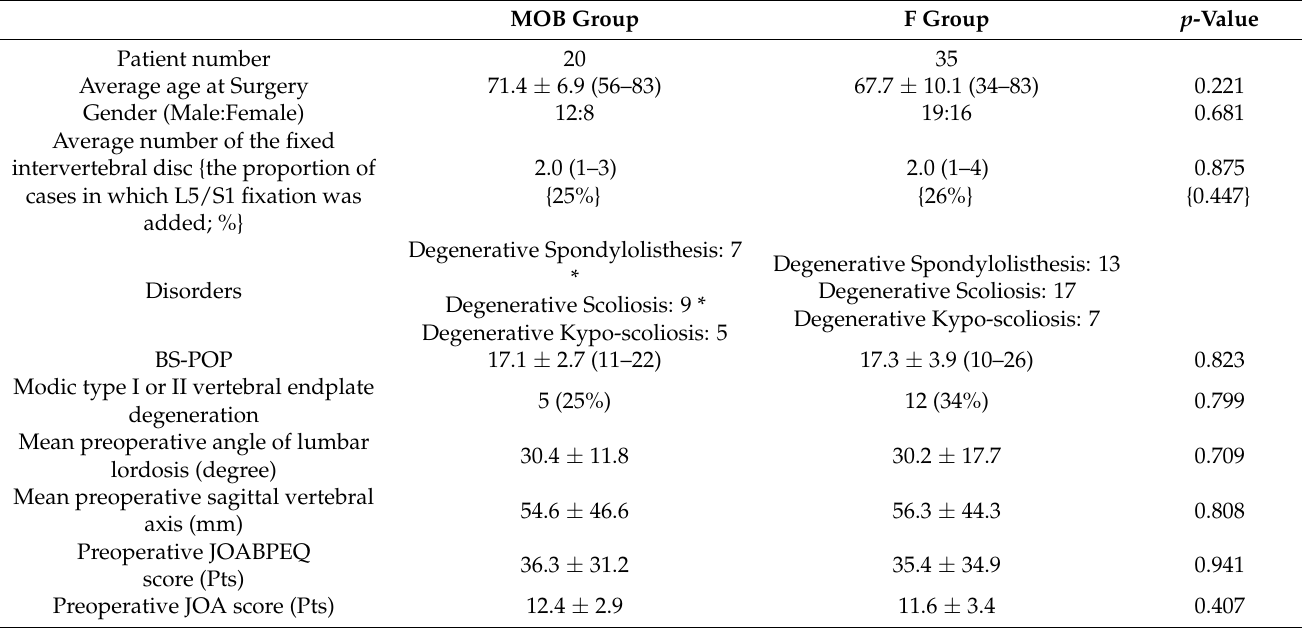
Table 1. Patient’s demographic